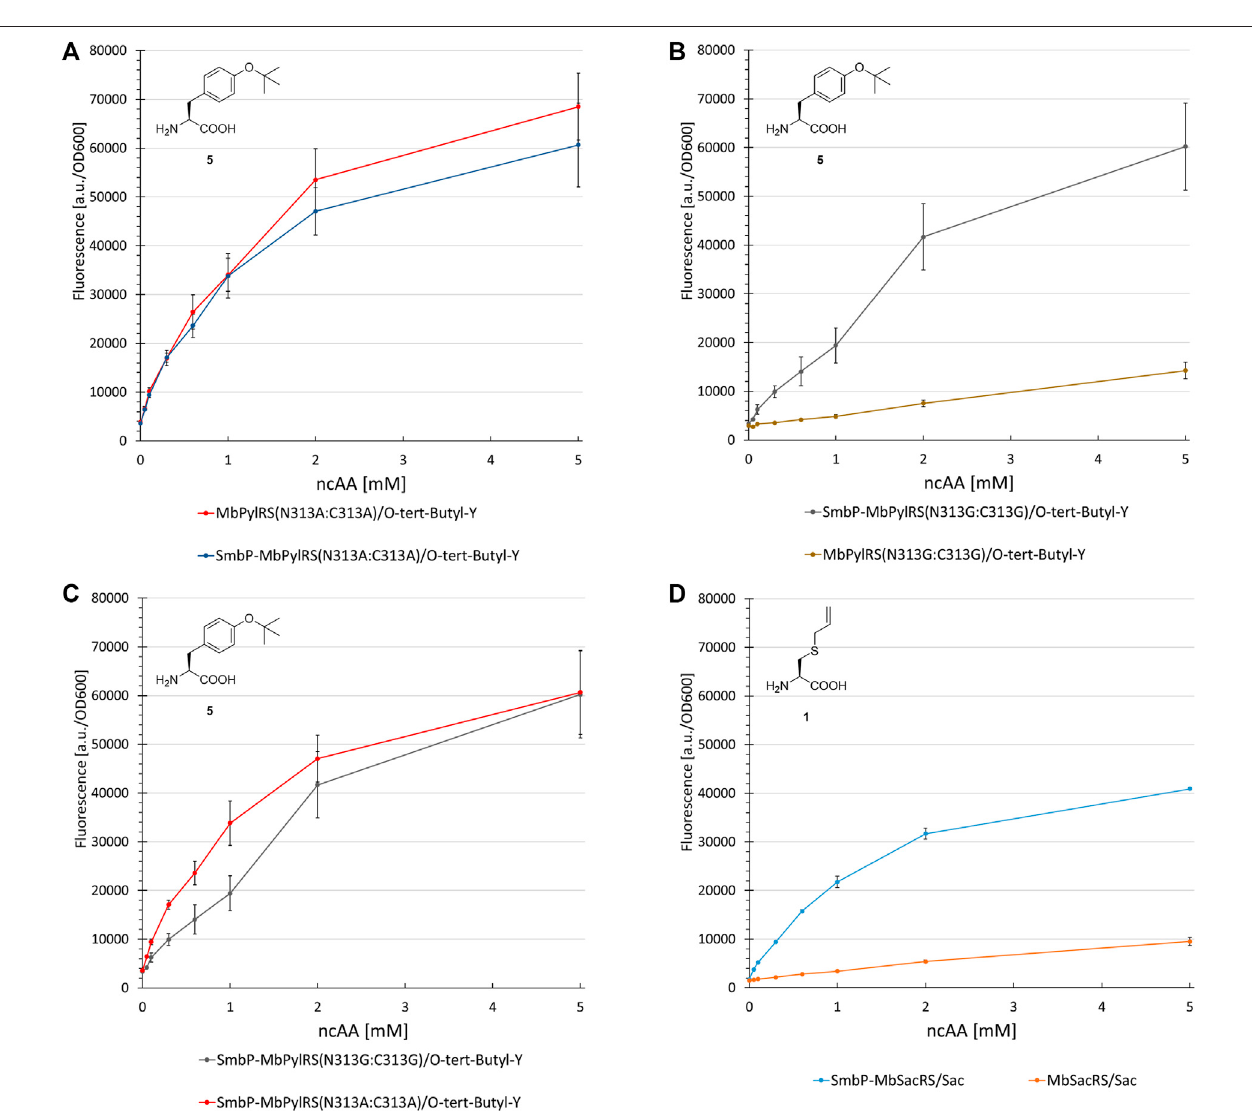
FIGURE 9 | Concentration dependent unnatural protein production for different combinations of SmbP- Mb PylRS/ Mb PylRS co-expression and ncAAs. Endpoint measurements for ncAA concentrations of 0.05, 0.1, 0.3, 0.6, 1, 2 and 5 mM.